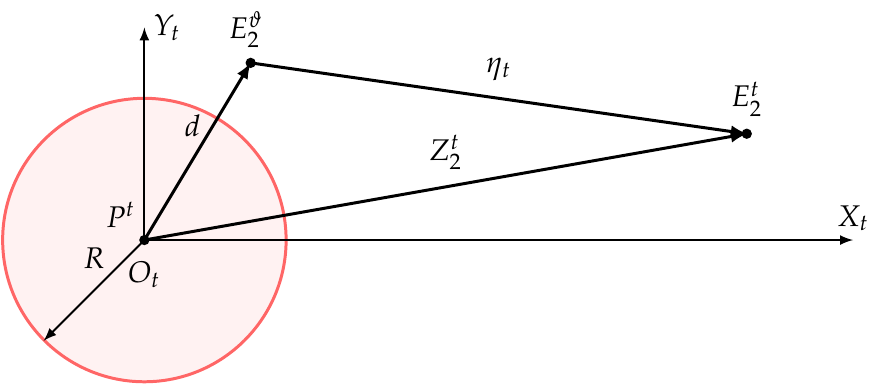
Figure 5. Geometry of the